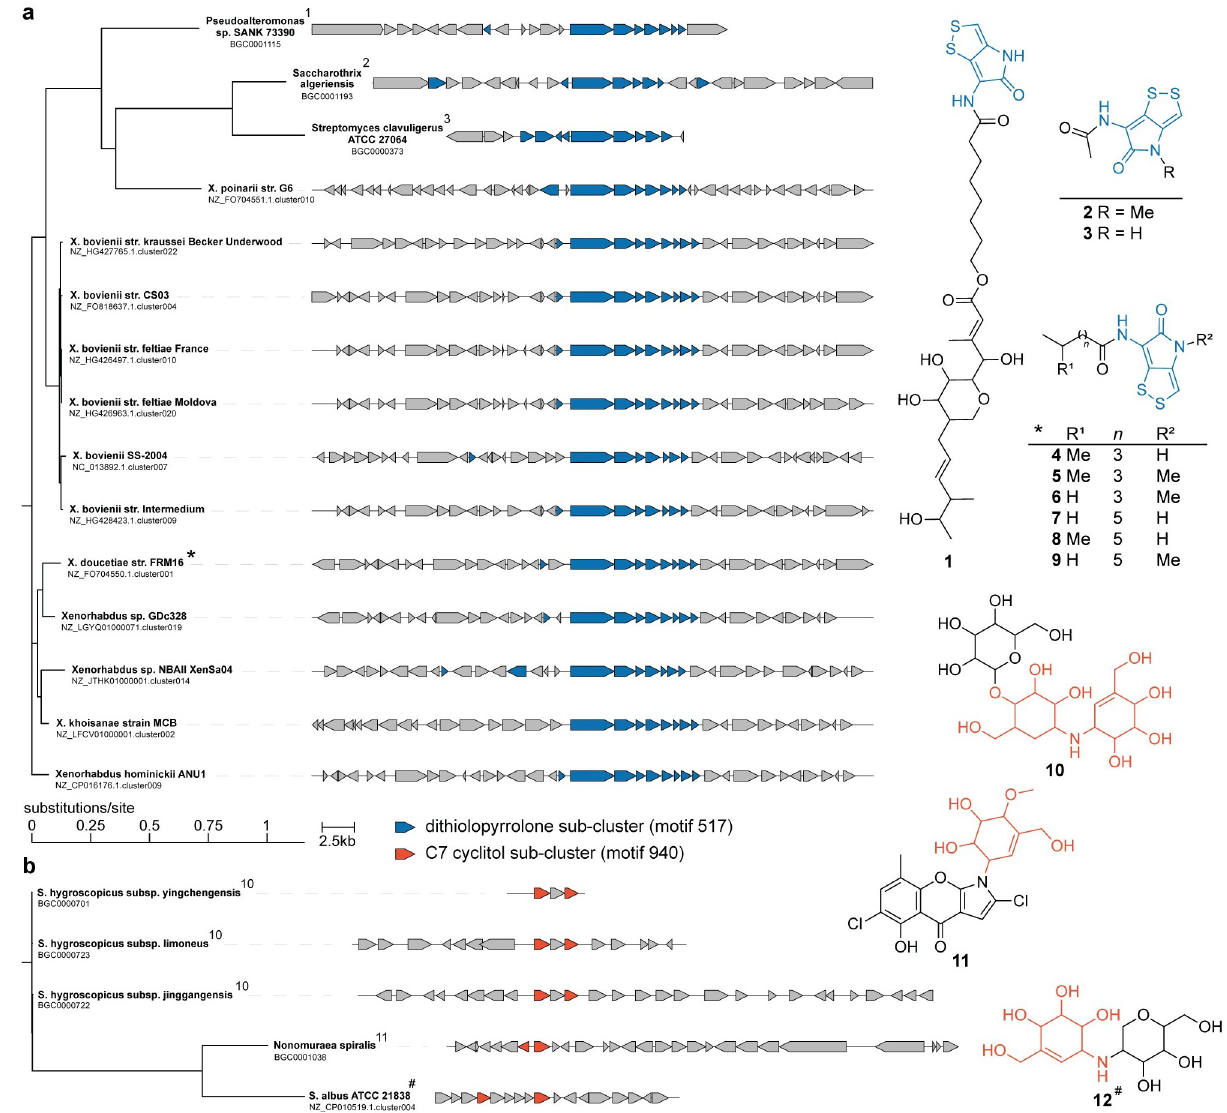
Fig 4. Connecting non-MIBiG BGCs to their metabolic products through iPRESTO-predicted sub-clusters. (a) Phylogenetic tree made with CORASON of 12 Xenorhabdus BGCs and 3 MIBiG BGCs, that contain an iPRESTO-predicted sub-cluster for dithiolopyrrolone biosynthesis [31]. The A-domain containing gene of NZ_FO704550.1.cluster001 was used as query for CORASON. Structures of thiomarinol (1), thiolutin (2) and holomycin (3) are linked to their MIBiG BGCs. Xenorhabdins (4–9) are encoded by X . doucetiae str. FRM16 as indicated by the asterisk, while we infer based on sub-cluster presence that the other Xenorhabdus BGCs are also responsible for xenorhabdin biosynthesis. (b) Phylogenetic tree made with CORASON NZ_CP010519.1.cluster004 from S . albus ATCC 21838 and 4 MIBiG BGCs, that contain an iPRESTO-predicted sub-cluster for C7 cyclitol biosynthesis. The predicted 2-epi-5-epi-valiolone synthase from NZ_CP10519.1.cluster004 was used as query for CORASON. Structures of validomycin A (10) and pyralomycin 1A (11) are linked to their MIBiG BGCs. Salbostatin (12) is encoded by S . albus ATCC 21838 as indicated by the hash symbol.